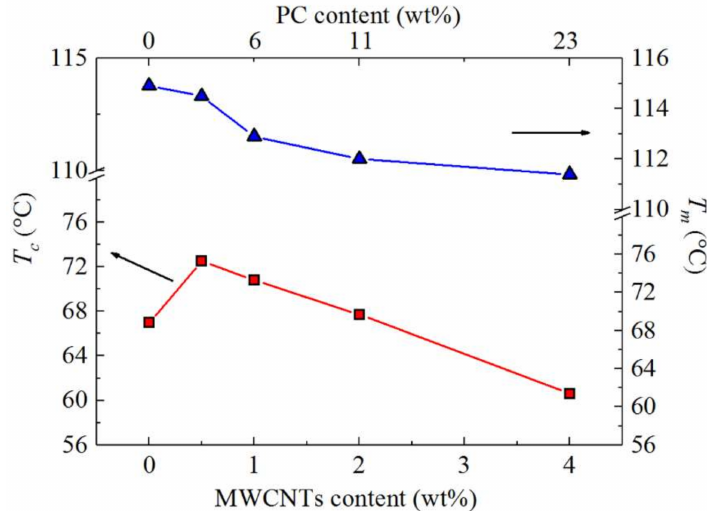
Figure 9. DSC crystallization and second heating melting temperatures as a function of MWCNTs content for neat PBS and the PBS/(PC/MWCNTs) nanocomposites (note that the PC content is indicated at the top